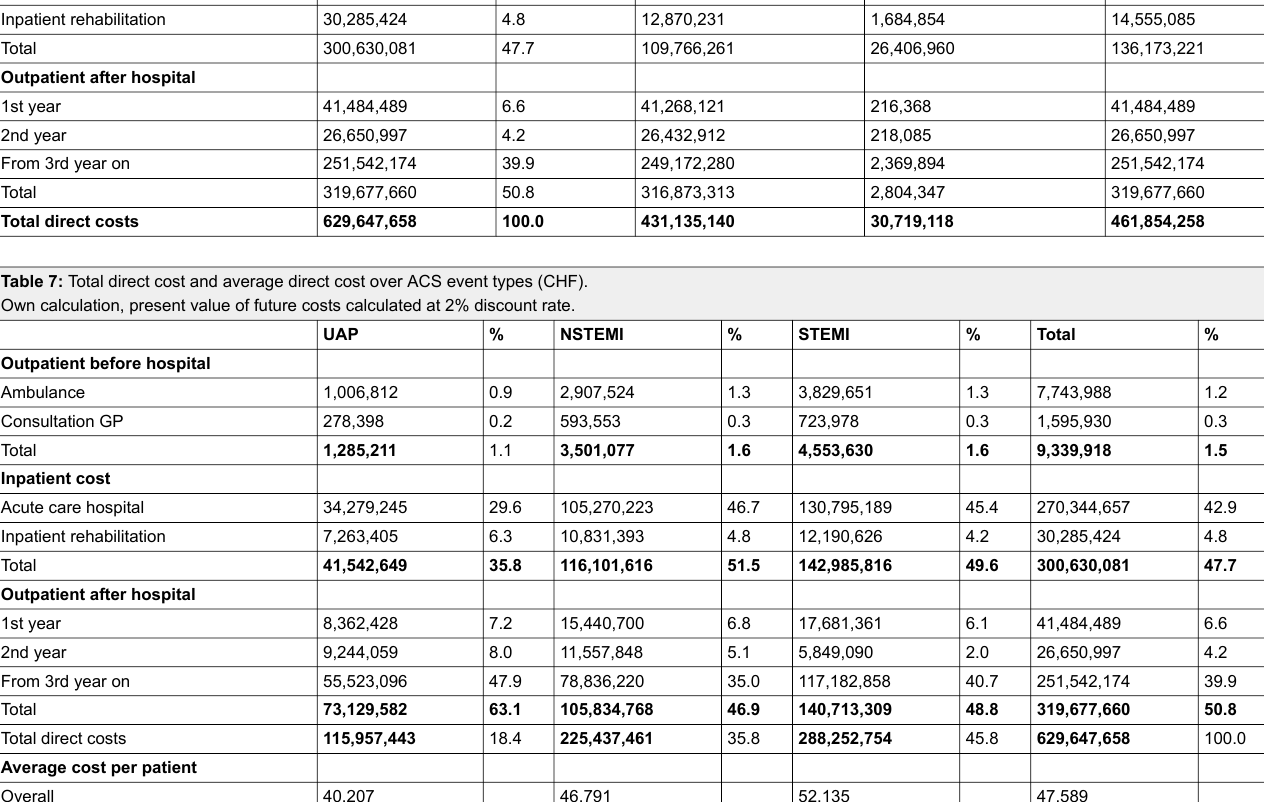
Table 6: Total direct cost of ACS occurring in Switzerland in 2008 (CHF). Own calculation, present value of future costs calculated at 2% discount rate. Societal perspective